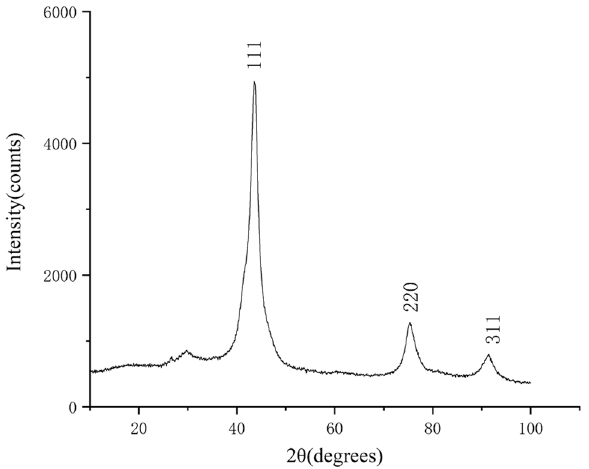
Figure 8. The XRD pattern of the purified product of the 10% MF experimental group. The horizontal coordinate indicates the diffraction angle and the vertical coordinate indicates the intensity of the diffraction peaks. The crystal planes corresponding to the three diffraction peaks are indicated.